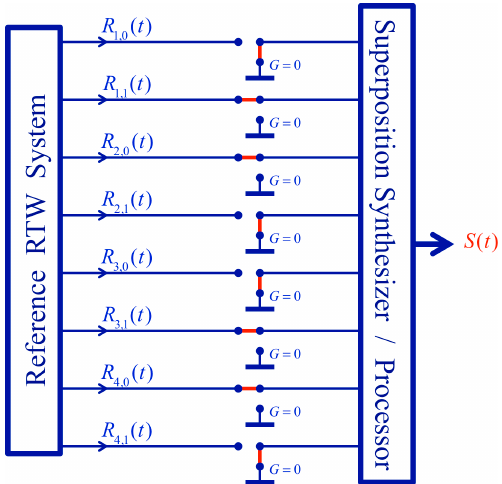
Figure 8. Switch arrangement for the instantaneous search of the 1(1),0(2),1(3),0(4) string in the superposition. The reference wires of the 1(1)-, 0(2)-, 1(3)-, and 0(4)-bit values are kept at their reference sources while the inverse bit values are grounded. If that string is not in the superposition, the superposition signal output S ( t ) will become zero.